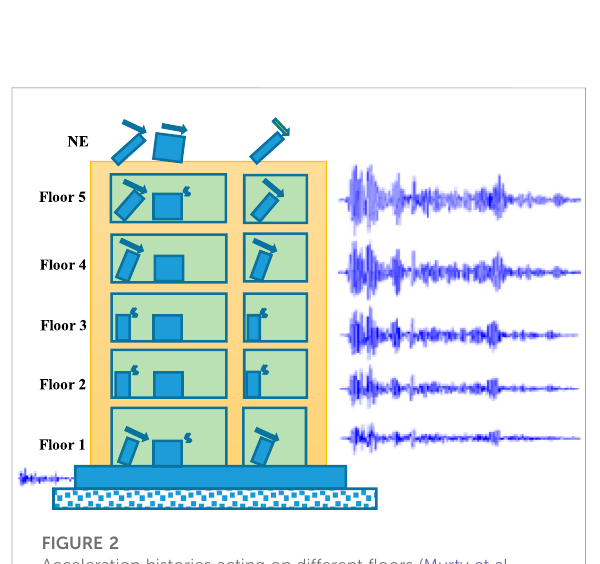
Acceleration histories acting on different fl oors (Murty et al., 2012; Cavuslu, 2022).